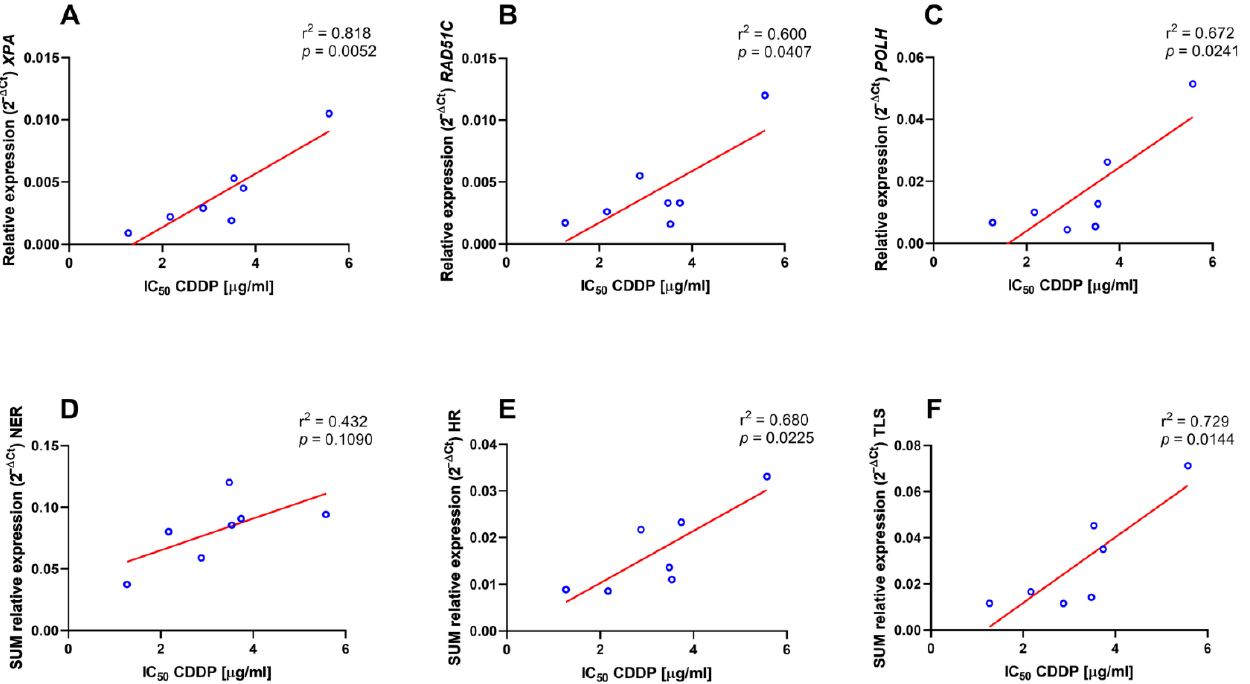
Figure 7. Correlation of relative basal mRNA expression of individual NER, HR and TLS factors as well as of cumulative expression of the NER, HR and TLS pathways with IC 50 values of continuous 48 h CDDP treatment. Correlation of basal mRNA expression levels of XPA ( A ), RAD51C ( B ) and POLH ( C ), as well as of cumulative NER ( XPA + ERCC1 + XPF + XPG ) ( D ), HR ( RAD51 + RAD51C + XRCC2 ) ( E ) and TLS ( REV3L + POLH + POLI ) ( F ) pathways with IC 50 values. The respective values of the coefficient of determination (r 2 ) and the p values are listed in the upper right corner of individual graphs.